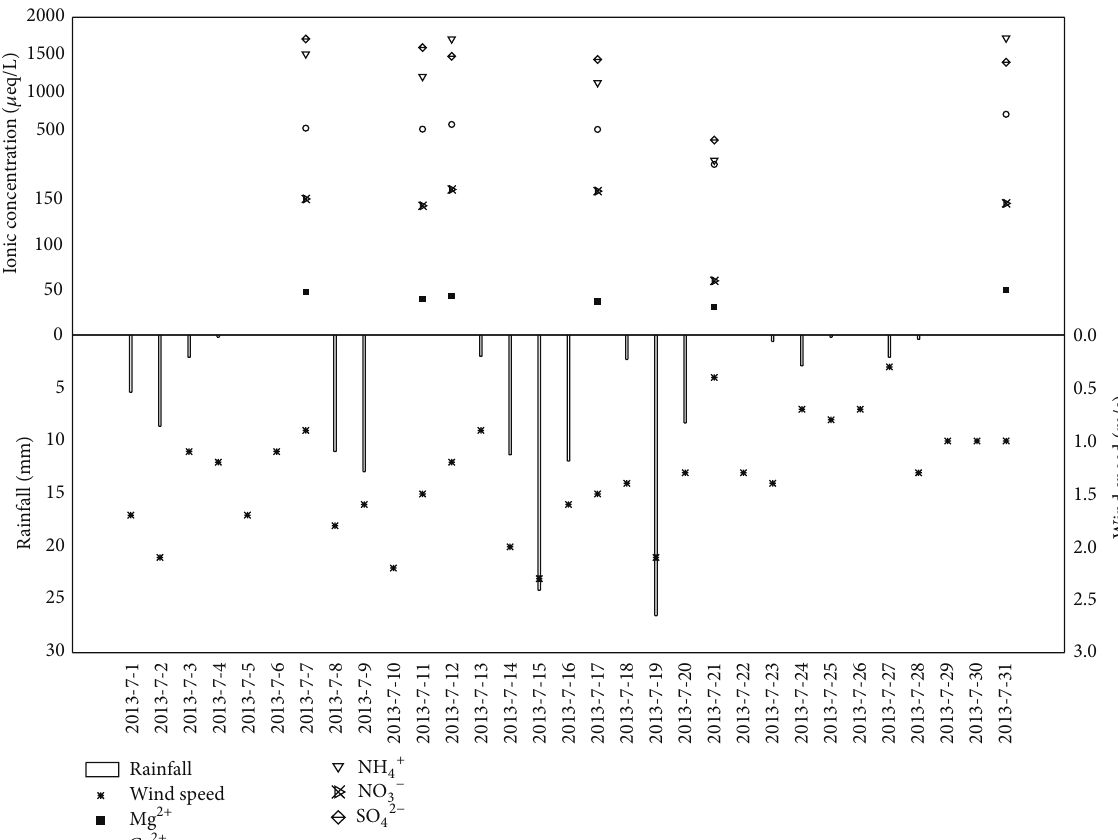
0.4 m/s and 2.5 m/s in Changchun. Therefore, the